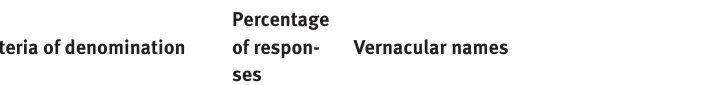
Table 5 : Meaning of termites vernacular names across study area (N =273)